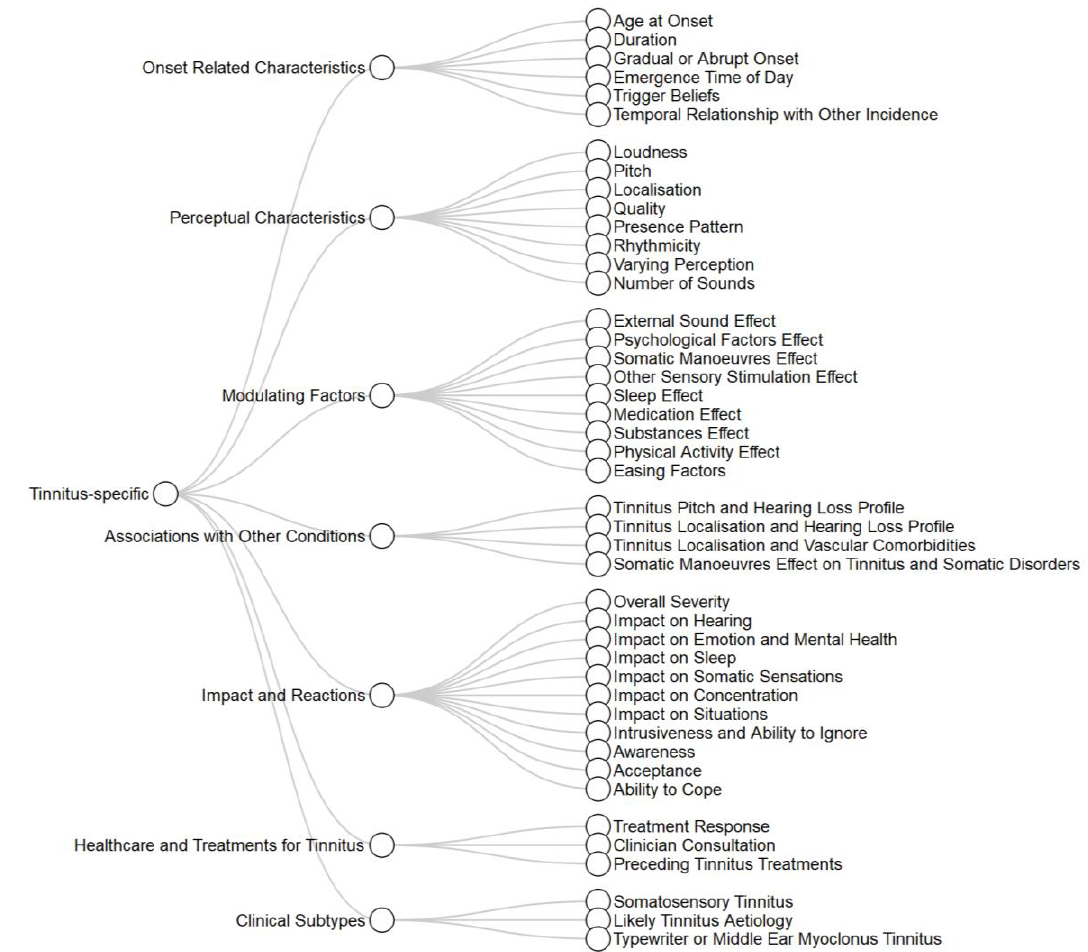
Figure 4. Tinnitus-specific variables.